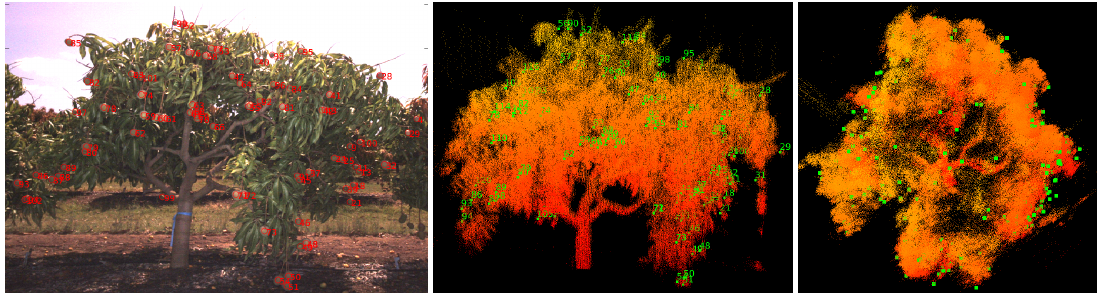
Figure 13. Triangulated 3D points of tracked fruit: ( a ) for the whole orchard block seen from above, with LiDAR coloured by tree number and triangulated fruit in black; ( b ) fruit locations and ids in a single image of one tree (r9t11n); ( c ) triangulated 3D fruit locations for the same tree, georeferenced with LiDAR data that are coloured by elevation and viewed from the same perspective as the image; ( d ) seen from